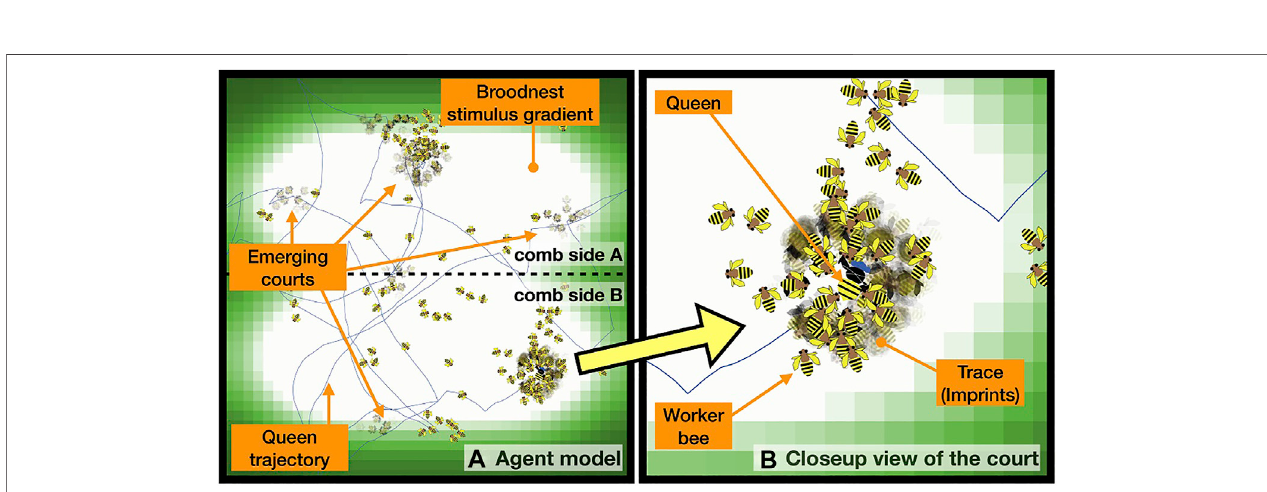
FIGURE7|(A) Queentrajectoryinatypicalmodelrun,imprints ofbodyshapesindicateplaceswhereworkerbeeagentsstoodstillforlongerperiodsoftimeinthe vicinity of the queen, indicating past court events at these places. (B) Close-up view of the court region.